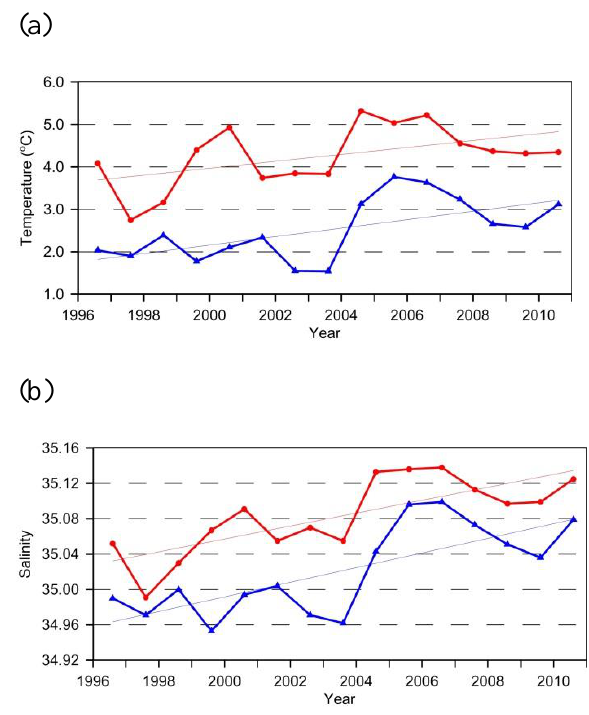
Fig. 17. Time series of mean (a) temperature and (b) salinity at Figure 17. Time series of mean (a) temperature and (b) salinity at 200 m depth, in 50 km wide 5 200m depth, in 50km wide zones of the eastern (red lines) and zones of the eastern (red lines) and western WSC branches. 6 western WSC